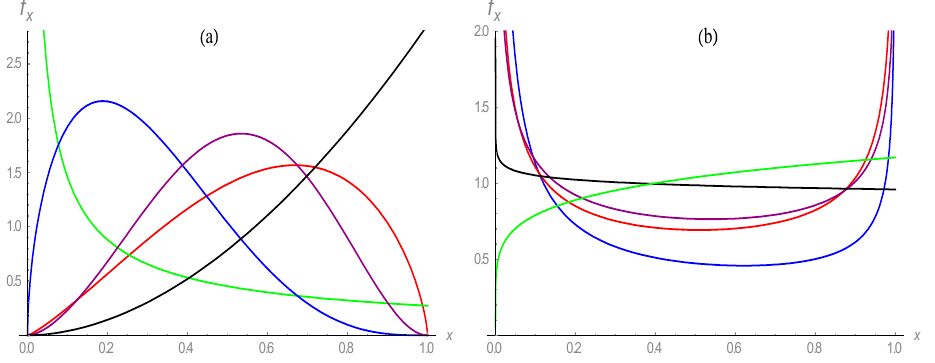
Figure 1. Plots of 3PBPDFs: ( a ) α = β = 1, δ = 1.3 (red), α = 1, β = 0.2, δ = 1.3 (green), α = 1, β = 2.2, Figure δ = 1.3 (black), α = 3, β = 1.9, δ = 1.4 (purple), α = 4, β = 1.2, δ = 1.3 (black). ( b ) α = 0.6, β = 0.2, δ = 1 (blue), α = 0.6, β = 0.5, δ = 1 (red), α = 0.7, β = 0.6, δ = 1 (purple), α = 1, β = 0.8, δ = 1.2 (black), α = 1, β = 0.9, δ = 1.3 (green). Table 1. Special cases of the 3PB. Table 1. Special cases of the 3PB. Parametric Values and Transformation in Parametric Values and Transformation in (3)